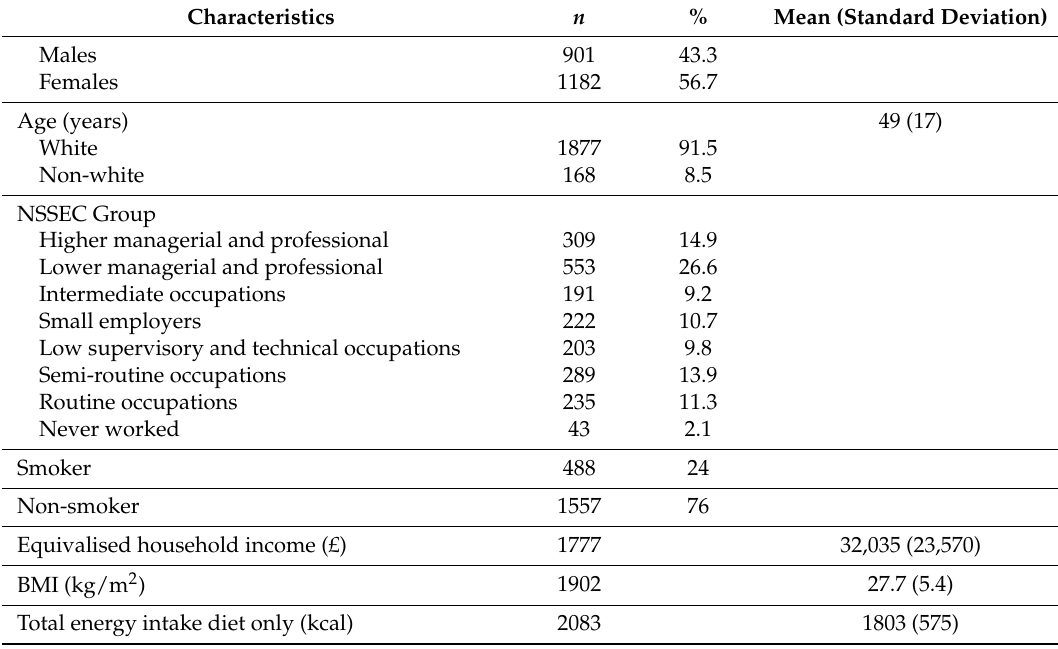
Table 2. Study population characteristics: National Diet and Nutrition Survey 2008–2012 ( n = 2083).